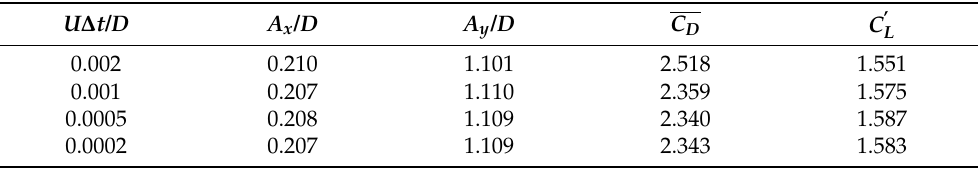
Table 2. Comparisons of results for an isolated cylinder for four different time-step sizes at Re = 20,000 and U r = 5. U ∆ t / D A x /D A y /D C D C ’